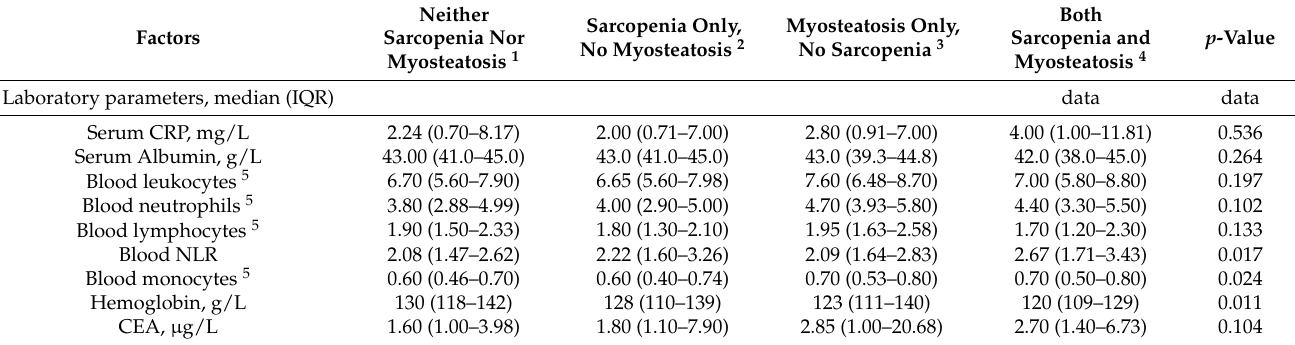
Figure 2. Correlation network between sarcopenia, myosteatosis, serum cytokines, CRP, Hb, and albumin established by the Cytoscape software platform utilizing the Perfuse force-directed algorithm. Variables are presented by nodes and their associations by edges. Correlations with p < 0.1 are shown and the edge length illustrates the significance of the association. The green edge illustrates a positive correlation between myosteatosis and NLR, and red edges negative correlations between sarcopenia/myosteatosis and other variables. Table 3. Serum cytokine and chemokine levels, blood cell counts, and other laboratory parameters in relation to sarcopenia and myosteatosis.